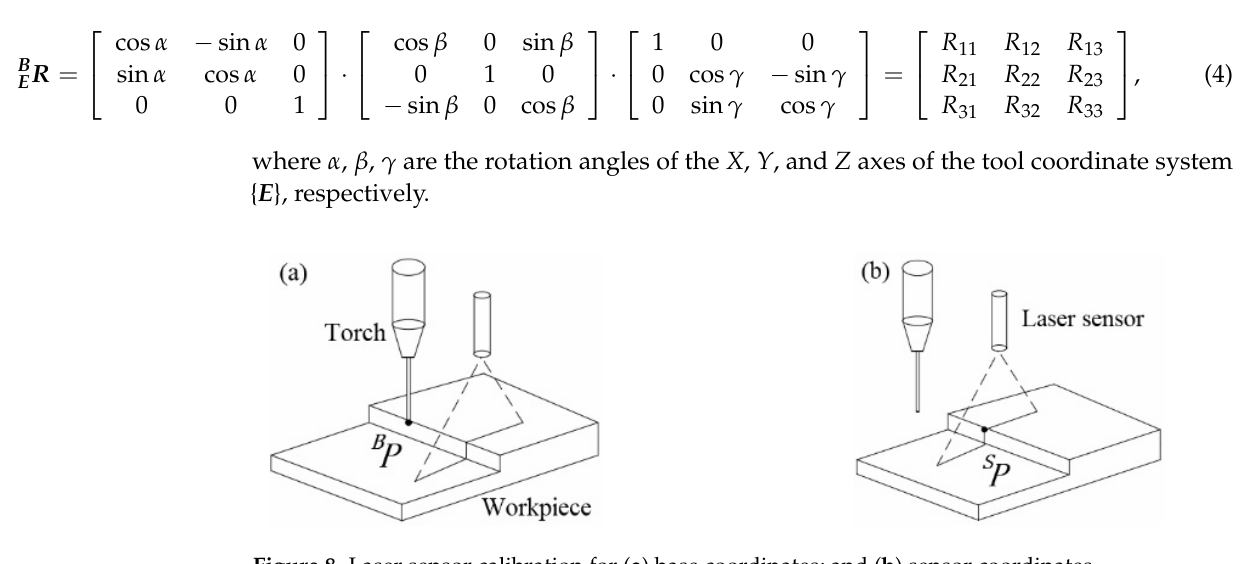
Figure 8. Laser sensor calibration for ( a ) base coordinates; and ( b ) sensor coordinates.